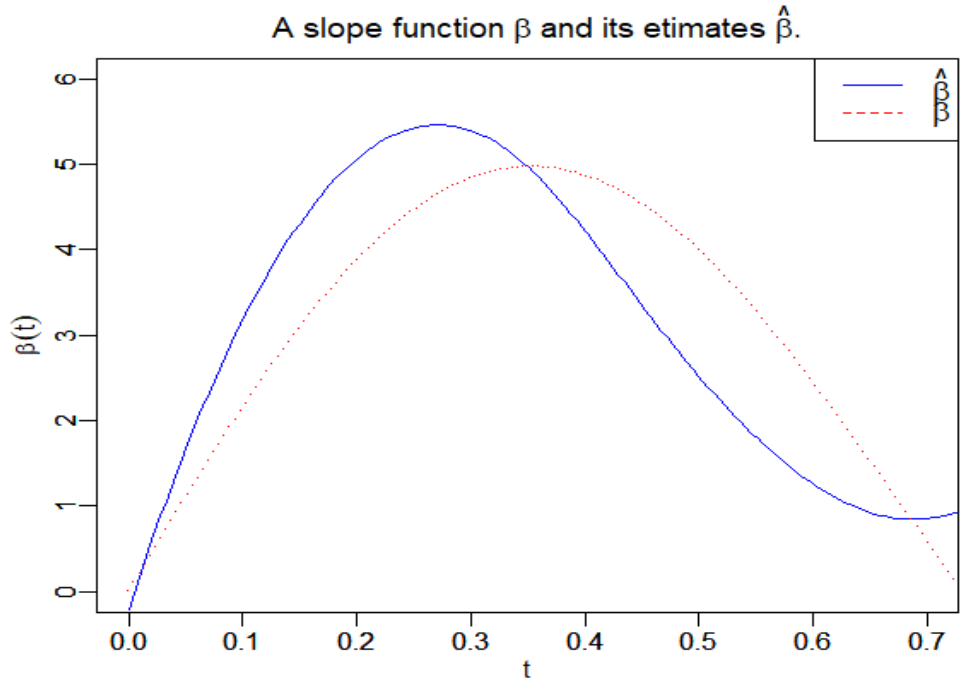
Figure 3. Estimated slope function ˆ β ( . ) and slope function β ( . ) . Our model approximates well the slope function β ( . ) .